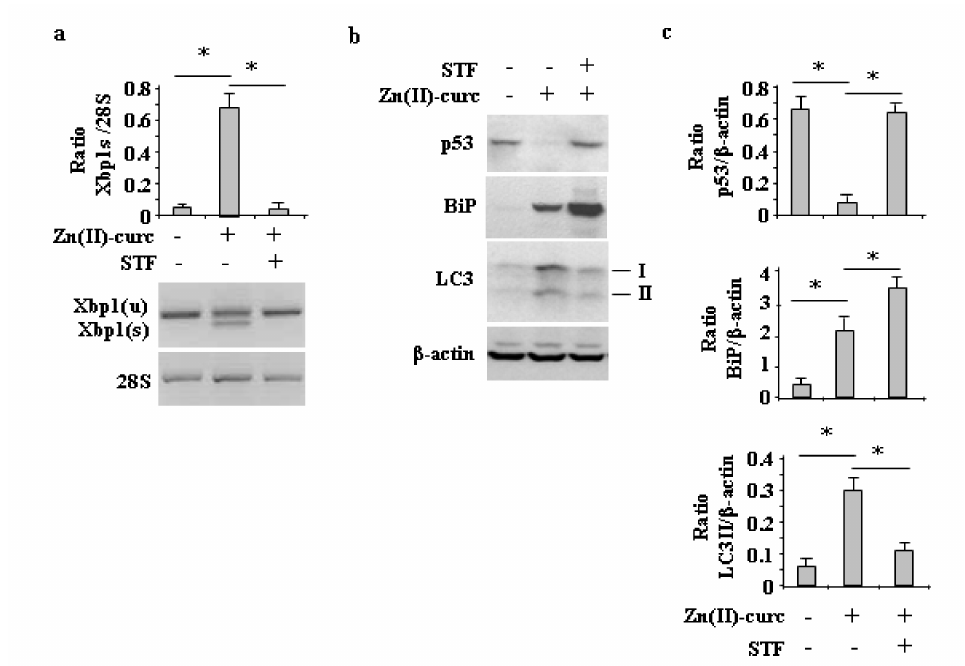
Figure 4. IRE1 α inhibition impairs Zn (II)-curc-induced autophagy and mutp53 degradation. ( a ) Total mRNA was extracted from U373 cells untreated or treated with Zn(II)-curc (100 µ g / mL) for 24 h, with or without inhibitor of XBP1 cleavage STF-083010 (STF) (60 µ M). Spliced (s) and unspliced (u) Xbp1 gene expression was assayed by the PCR of reverse-transcribed cDNA. (lower panel) Densitometric analysis was performed using Image J software to calculate the Xbp1s / 28S ratio. Histograms represent the mean ± SD of three independent experiments. * p ≤ 0.05. ( b ) Western blot analysis of p53, BiP, and LC3I / II protein levels in U373 cells untreated or treated, as in ( a ). ( c ) Densitometric analysis was performed using Image J software to calculate the ratio of the protein levels, as detected in ( b ), vs. β -actin. Histograms represent the mean ± SD of three independent experiments. * p ≤